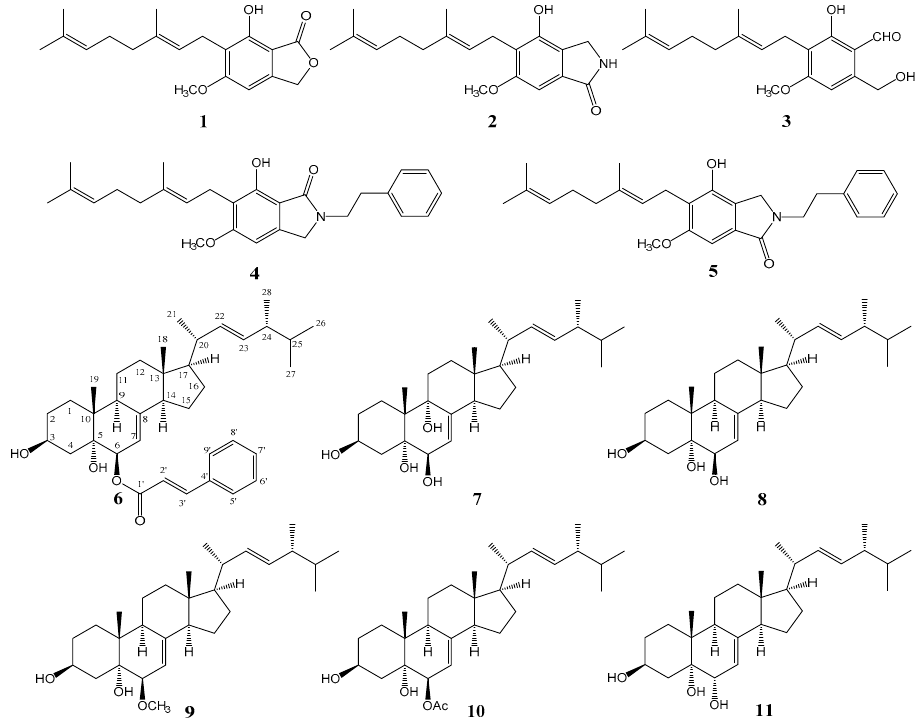
Figure 1. Structures of compounds 1 – 11 isolated from cultures of H. erinaceum .